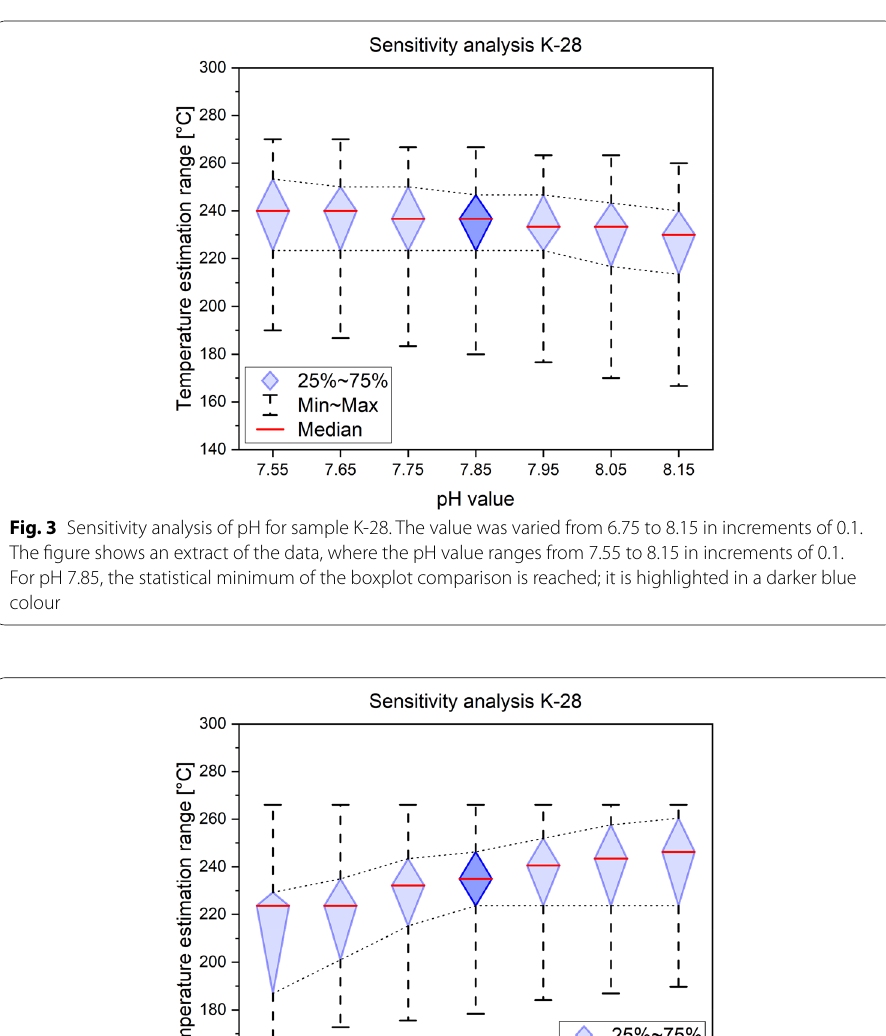
sition for K-28 is 0.039 mmol/kg. In Fig. 4, an optimal concentration is also reached at 0.039 mmol/kg.